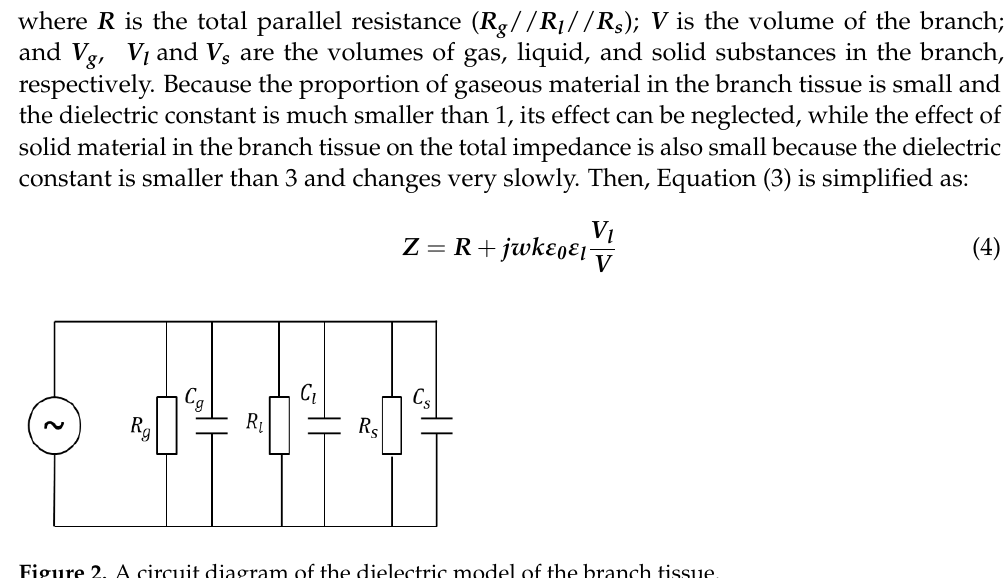
Figure 2. A circuit diagram of the dielectric model of the branch